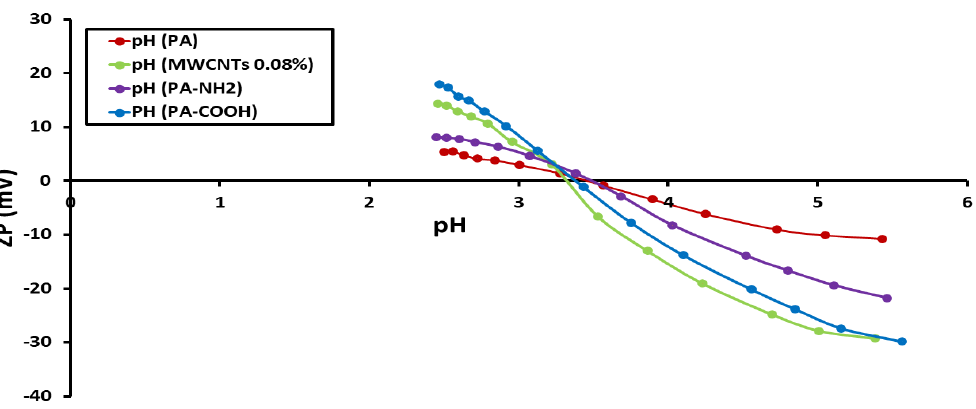
Figure 5. Zeta potentials of PA and PA-MWCNTs, PA-MWCNTs-COOH, and PA-MWCNTs-NH 2 membranes as a function of pH.